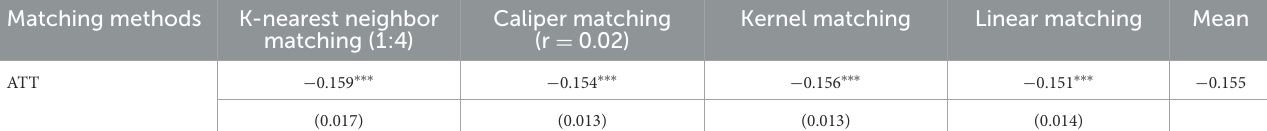
TABLE 4 Propensity score matching results.